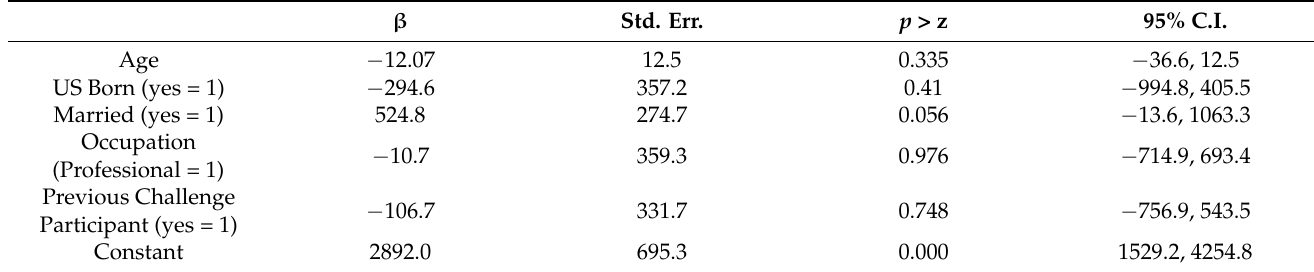
Table 4. GEE regression results predicting percent change from